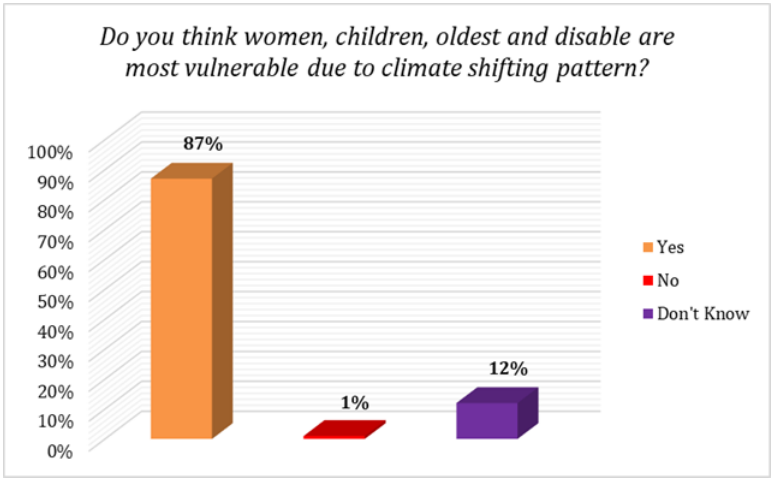
Figure 3. Vulnerability of population type to shifting climate patterns; Source: Field Survey, 2017– 2019 [Whereas, yes (male 60.36%, female 26.64%); No (male 0.69%, female 0.31%); Don’t know (male 8.32%, female 3.68%)].